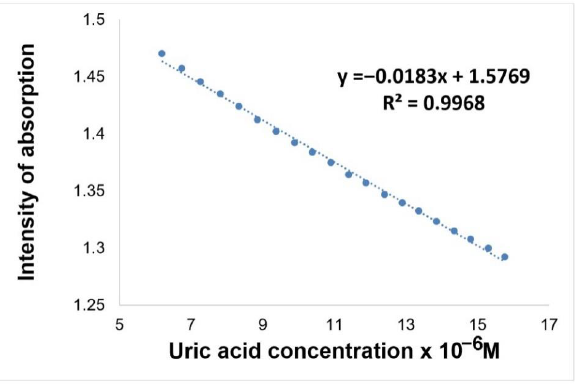
Figure 21. Linear dependence between absorption intensity of TAmPP-PtNPs hybrid material and uric acid concentration. Interference Study